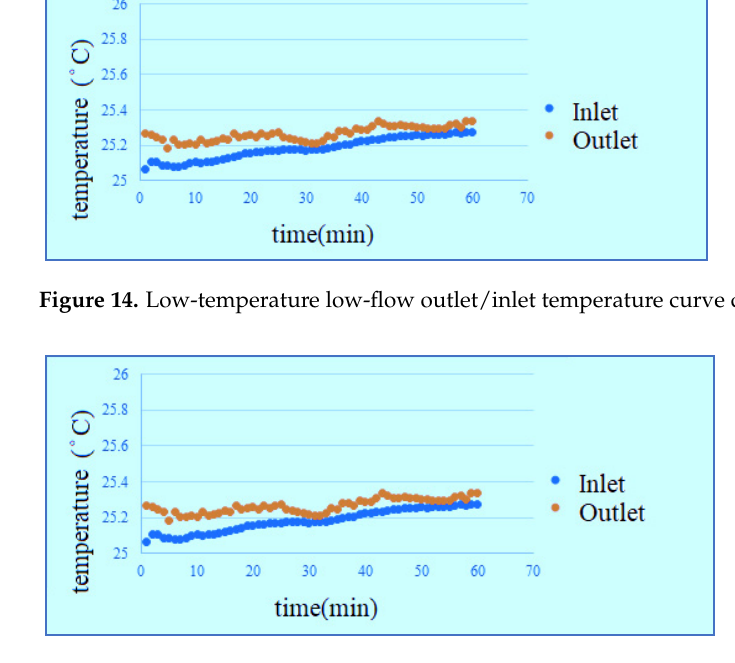
Figure 16. High-temperature low-flow outlet/inlet temperature curve diagram. Figure 17. High-temperature high-flow outlet/inlet temperature curve diagram. 4.4. Humidity Distribution Inside Water Electrolyzer According to the data, the humidity at the outlet/inlet is 100% in the reaction process, the resistive micro humidity sensor has ±10% error due to temperature effect, as shown in Figure 18. Because it is measured under different conditions, the conversion of the envi- ronment causes errors in the measurement of the measurement equipment. Figure 18. Outlet/inlet humidity curve diagram.